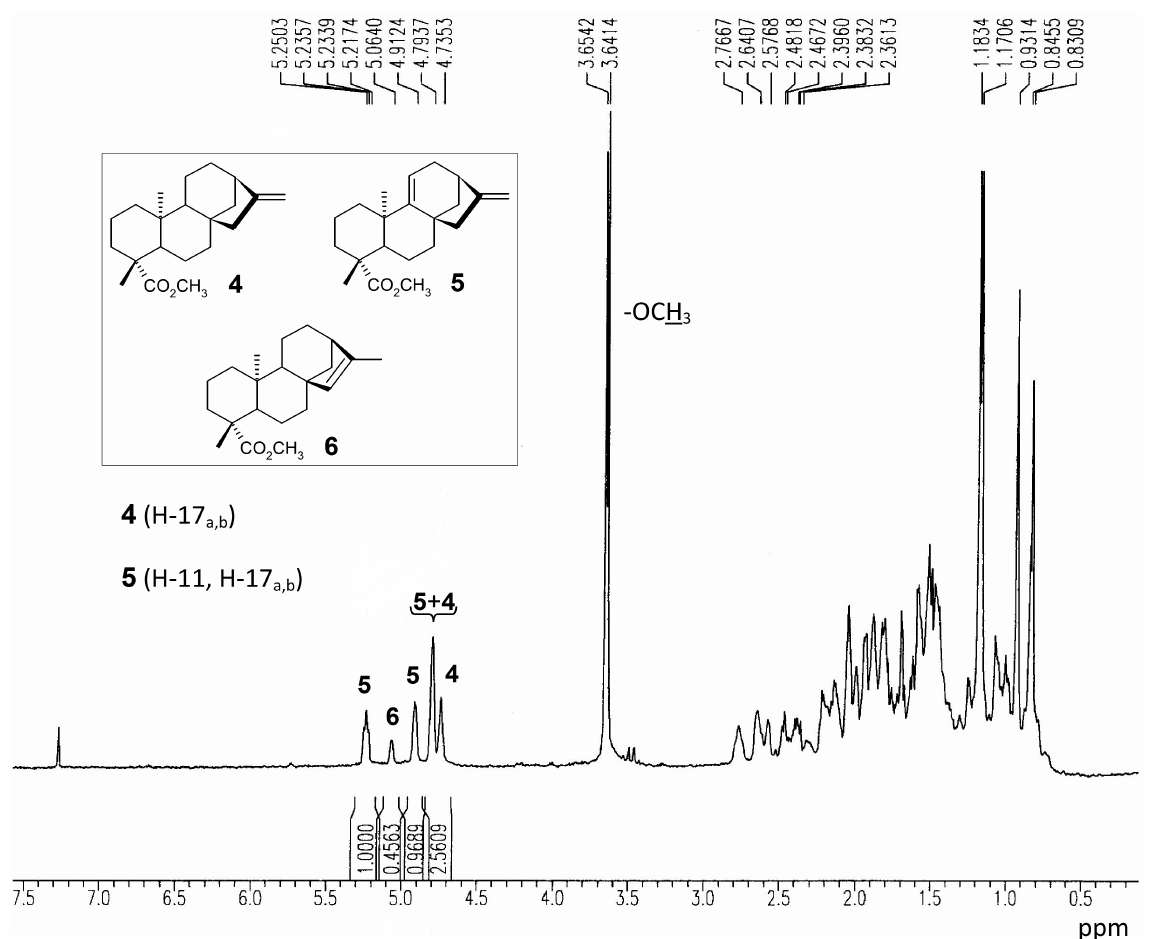
Fig. 1 – 1 H NMR spectrum (200 MHz, α /ppm, CDCl 3 ) for the mixture of methyl esters 4+5+6